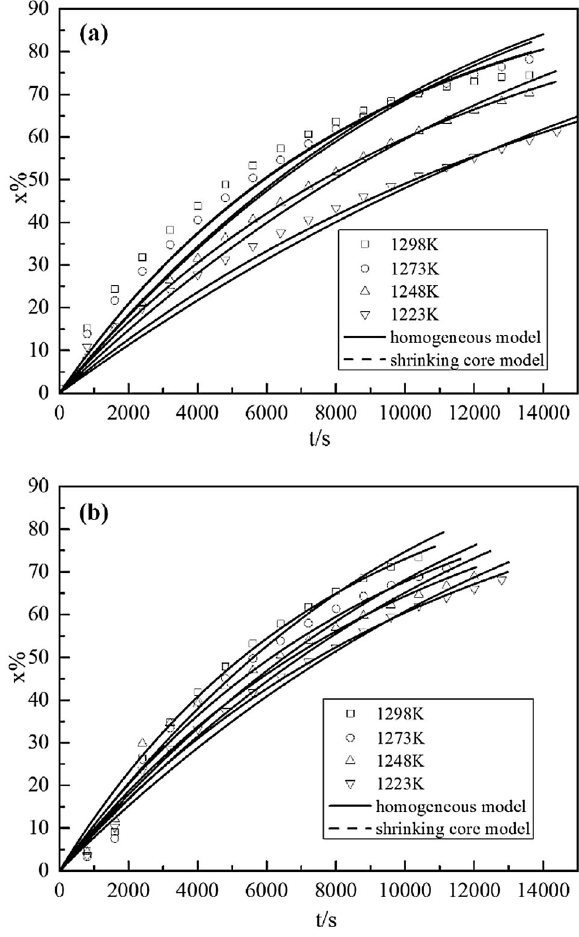
Fig. 9 Comparison between a raw coke samples and b samples adsorbed Na 2 CO 3 experimental data and those predicted by the